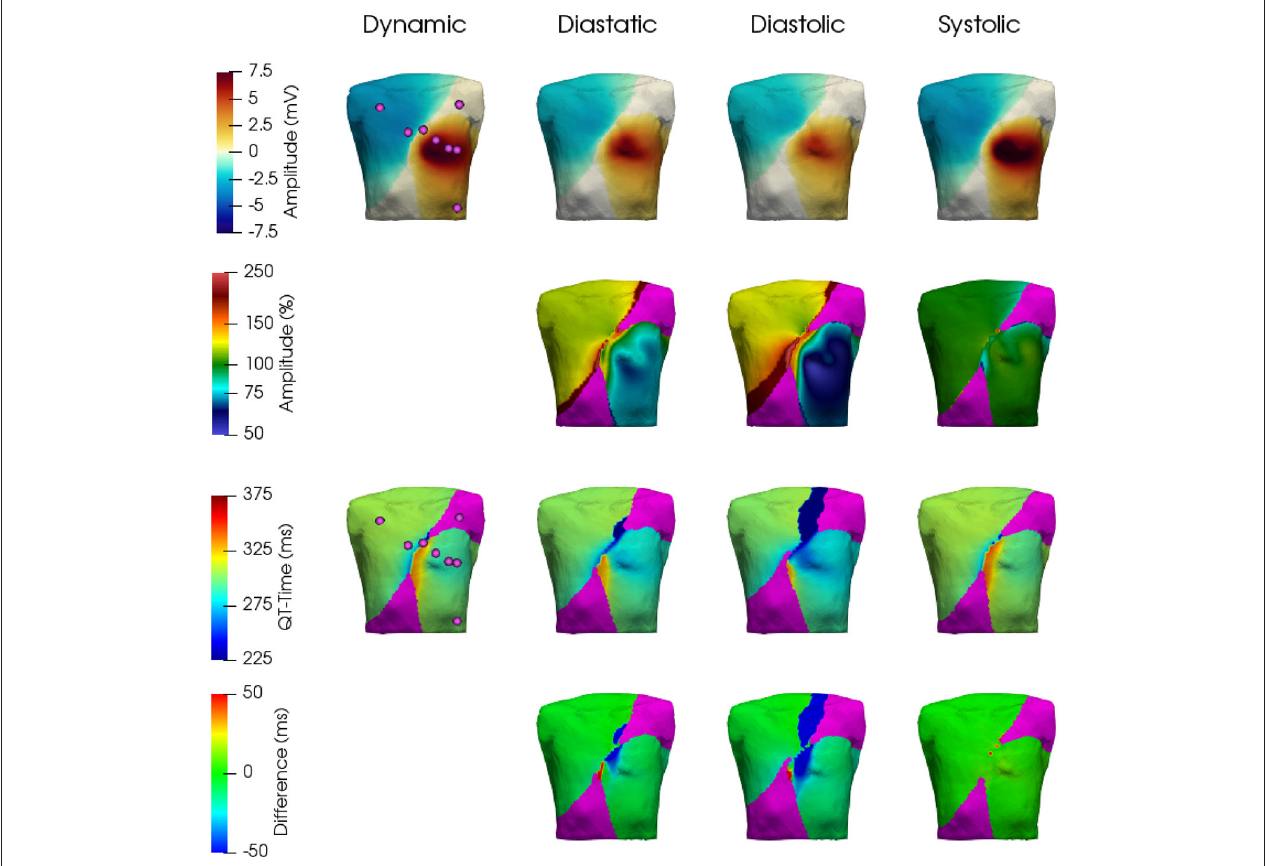
FIGURE 9 | Comparison of resulting T-Wave amplitudes and durations. Top row: T-Wave amplitudes extracted from the BSPM for the four cases—dynamic, diastatic, diastolic, systolic. 2nd row: T-Wave amplitudes in % with respect to the dynamic case. 3rd row: T-Wave extracted from the BSPM. 4th row: Difference in ms of the three static cases with respect to the dynamic one. The area shown in Magenta was ignored, as the absolute T-Wave amplitude here was below